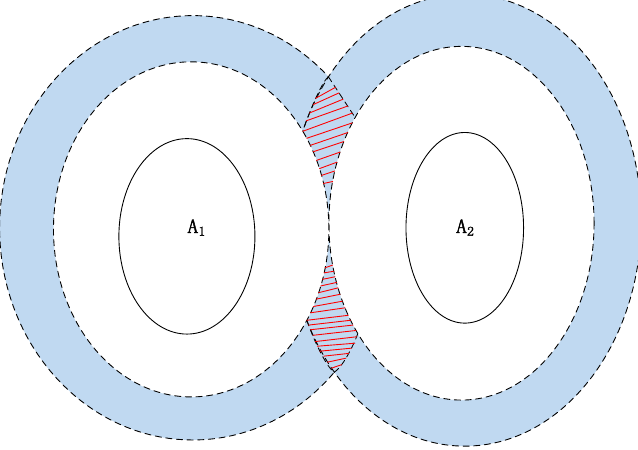
Figure 9. Definition of fuzzy band and admissible domain. The blue bands correspond to the fuzzy bands of objects A 1 and A 2 (e.g., Fuzzy_Band(A 1 ), Fuzzy_Band(A 2 )); the red dashed regions correspond to the admissible domain (e.g., Admiss_Dom(A 1 ,A 2 )).